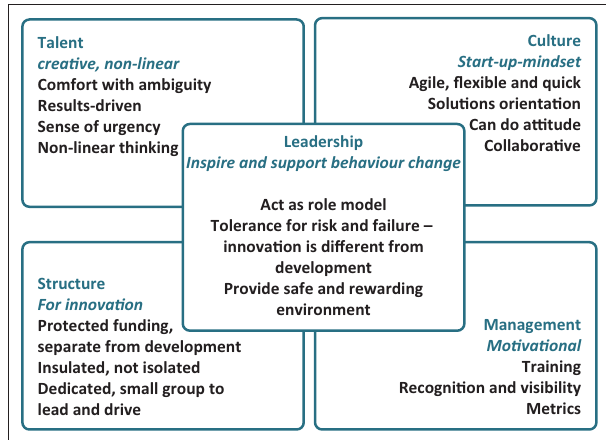
FIGURE 4: Innovation culture (PricewaterhouseCoopers [PwC] digital services).